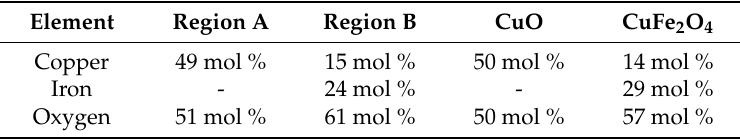
Figure 2. EDX pattern of the delafossite, annealed at 900 ◦ C for 12 h in a gas mixture of 10% oxygen in nitrogen. ( a ) copper; ( b ) iron; ( c ) oxygen. Table 1. Calculated element mole fraction based on the quantitative EDX analysis of the two regions marked in Figure 2 and the theoretical composition of CuO and CuFe 2 O 4